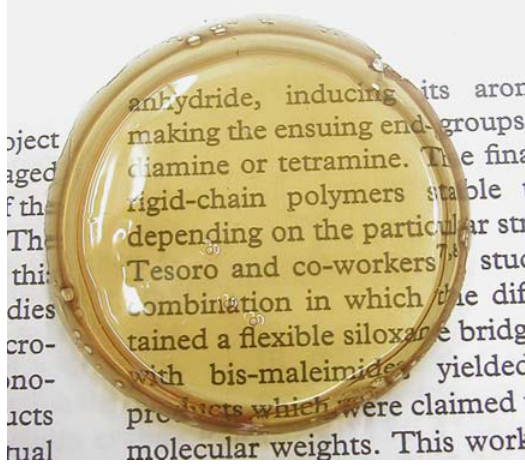
Figure 2. Photograph of the as-cast film of